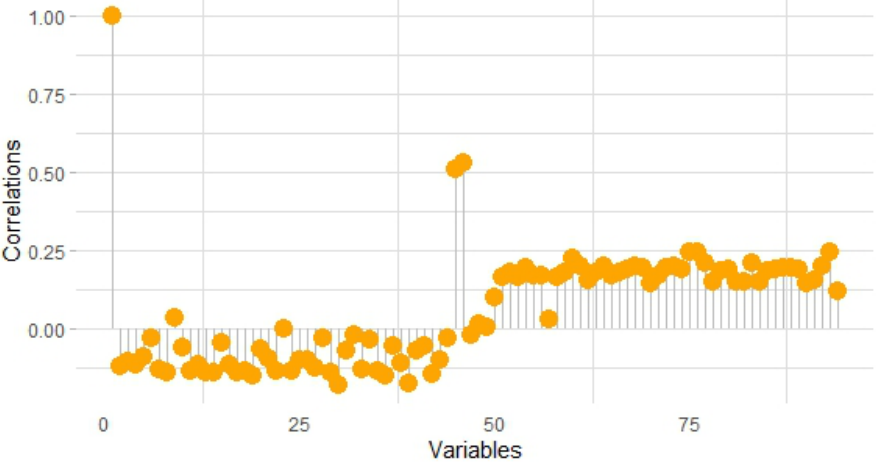
Figure 8. Pearson correlations between age (year of birth) and all predictors. Variables 2-44 and 51-94 were extracted from answers and questions,